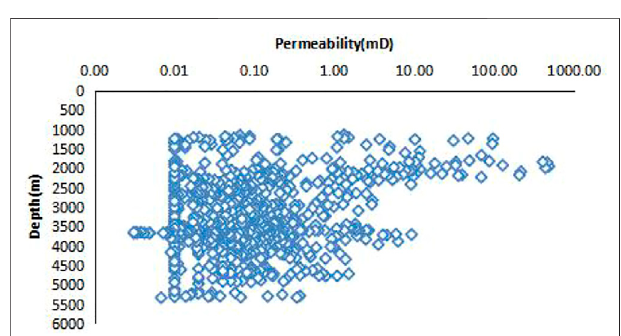
FIGURE 11 | Relationships between the permeability levels and the depths of the Upper Paleozoic reservoirs in the Dongpu Depression (Zhang, 2018).